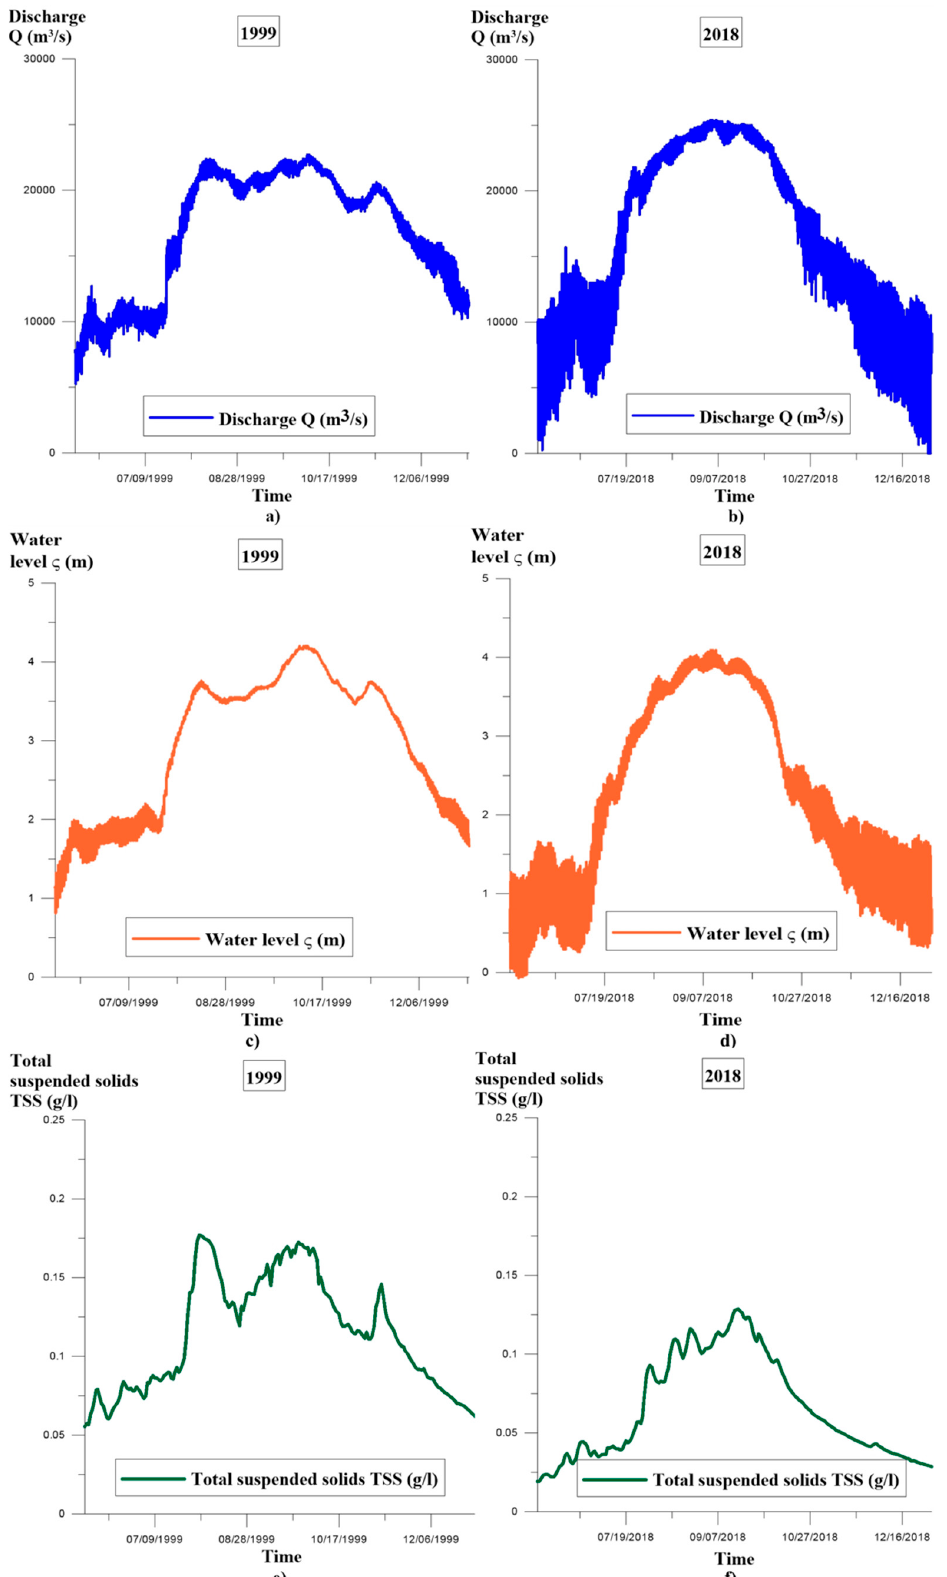
Figure 4. Input discharge Q ( t ) in 1999 ( a ) and 2018 ( b ); input water level ς ( t ) in 1999 ( c ) and 2018 ( d ); and the input total suspended solids (TSS) C ( t ) in 1999 ( e ) and 2018 ( f ).